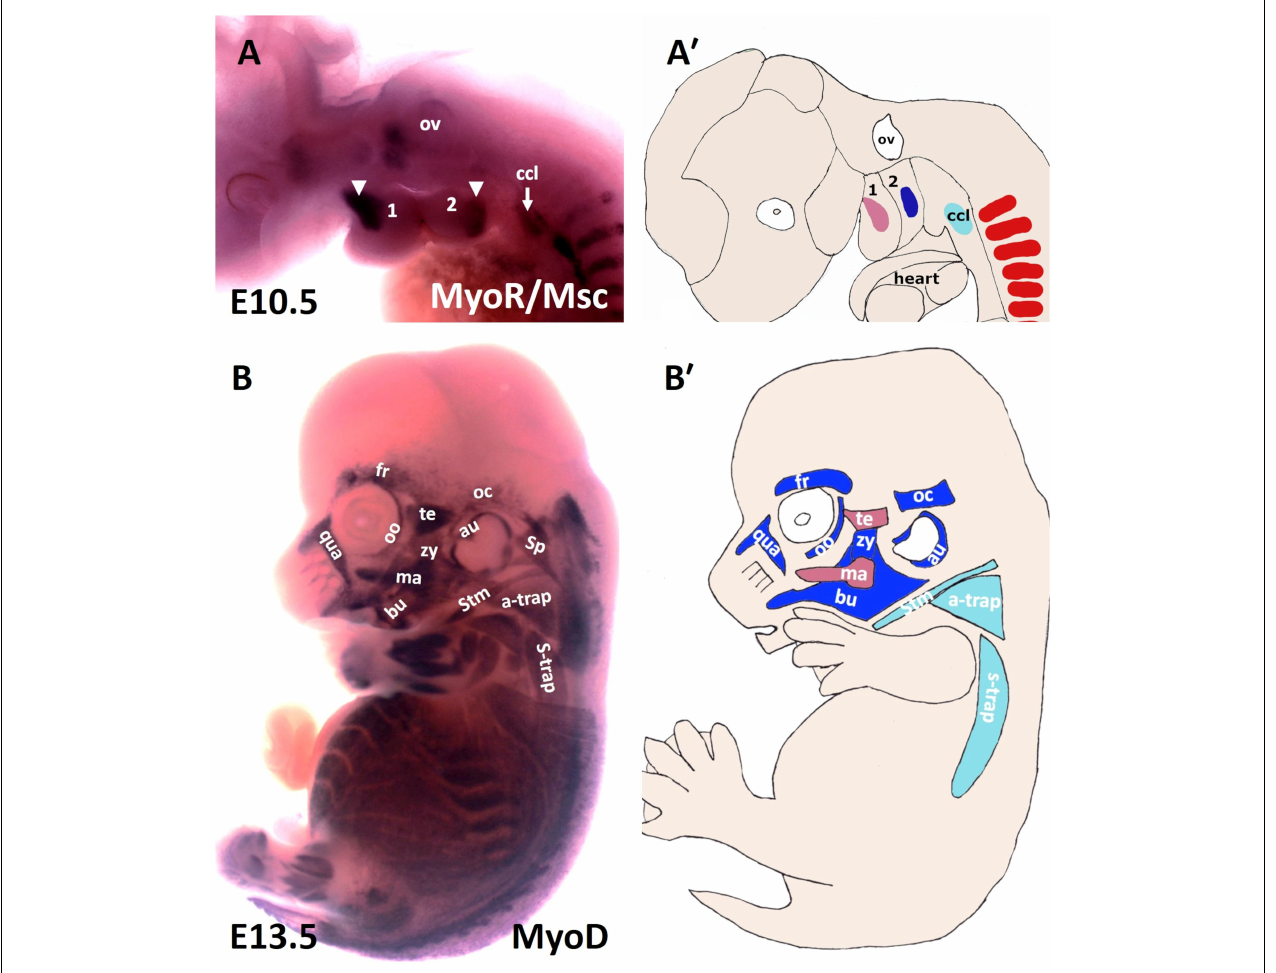
FIGURE 1 | Muscles of the mouse head and neck. (A) Lateral view of a stage E10.5 mouse embryo hybridized with a MSC (MyoR) probe. (A (cid:48) ) Schematic representation of E10.5 mouse embryo in the panel (A) . In pink: first arch-derived muscle anlage. In blue: second arch-derived muscle anlage. In pale blue: cucullaris muscle anlage. MSC marked the myogenic core of the BA1 and BA2. Cucullaris muscle anlage is also labeled with MSC. (B) Lateral view of a stage E13.5 mouse embryo hybridized with a MyoD probe. (B (cid:48) ) Schematic representation of E13.5 mouse embryo in the panel (B) . MyoD is expressed in all branchiomeric muscles and cucullaris muscle anlage. a-trap, acromio-trapezius; au, auricularis; BA1-2, branchial arches 1–2; bu, buccinator; ccl, cucullaris anlage; fr, frontalis; ma, masseter; oc, occipitalis; oo, orbicularis oculi; ov, otic vesicle; qua, quadratus labii; sp, splenius; stm, sternocleidomastoideus; s-trap, spino-trapezius; te, temporalis; zy,